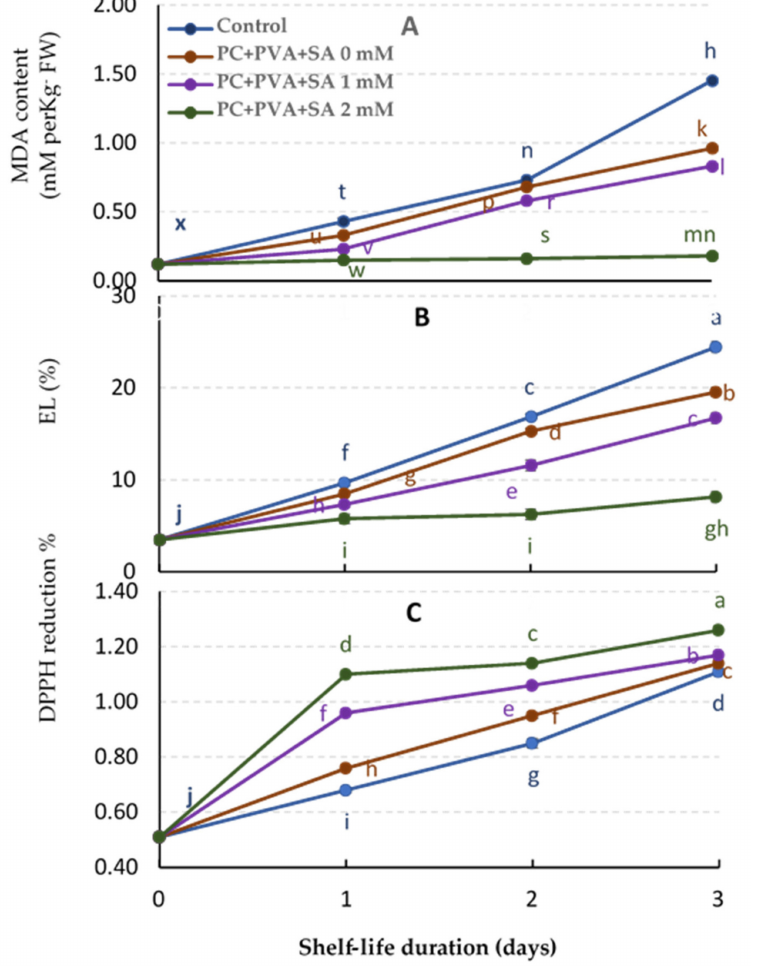
Figure 7. Melanodialdehyde accumulation (MDA; ( A )), electrolyte leakage (EL%; ( B )), and DPPH* percentage ( C ) of ‘Crimson seedless’ grapes coated with PE + PVA blending with SA at different concentrations (0, 1, and 2 mmol L − 1 ) and stored at room temperature (26 ± 1 ◦ C and 65 ± 5% RH) for 3 d. Each value represents a mean of three replicates, with error bars representing standard errors ( ± SE), and different letters indicate significant differences at p ≤ 0.05 between treatments. Mean comparisons were performed between all